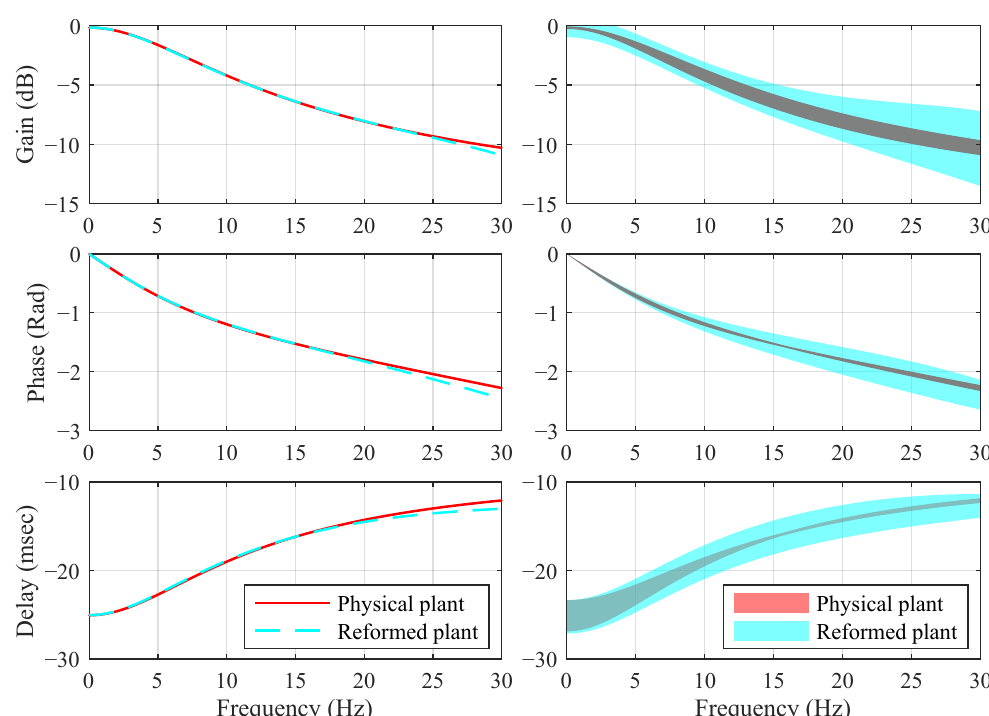
Figure 11. Frequency responses of physical and reformed plants ( left : nominal models; right : models with